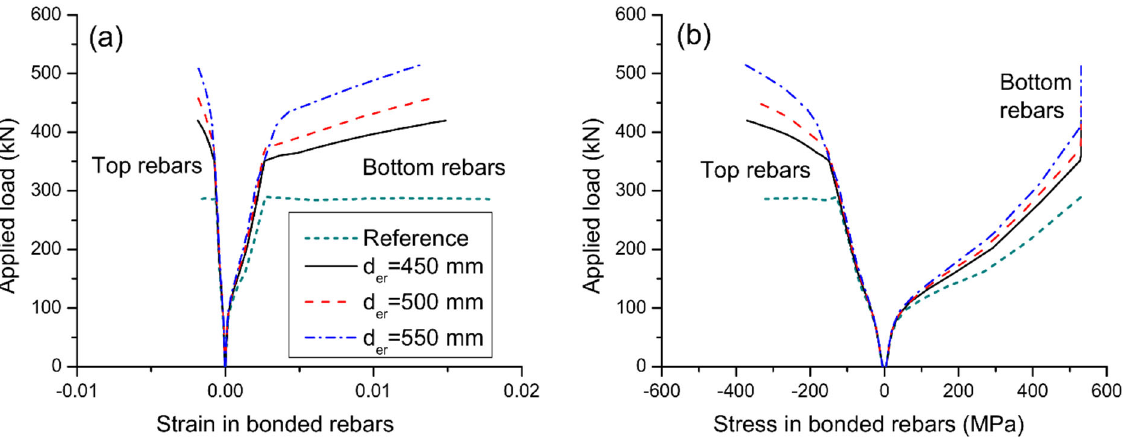
Figure 13. Effect of reinforcement depth on the behavior of bonded rebars at midspan. ( a ) develop ‐ ment of rebar strain; ( b ) development of rebar stress.